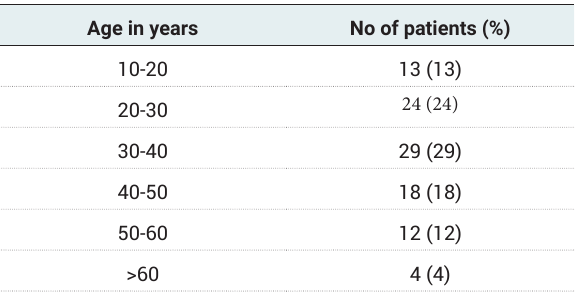
Table 1: Distribution of patients according to the age